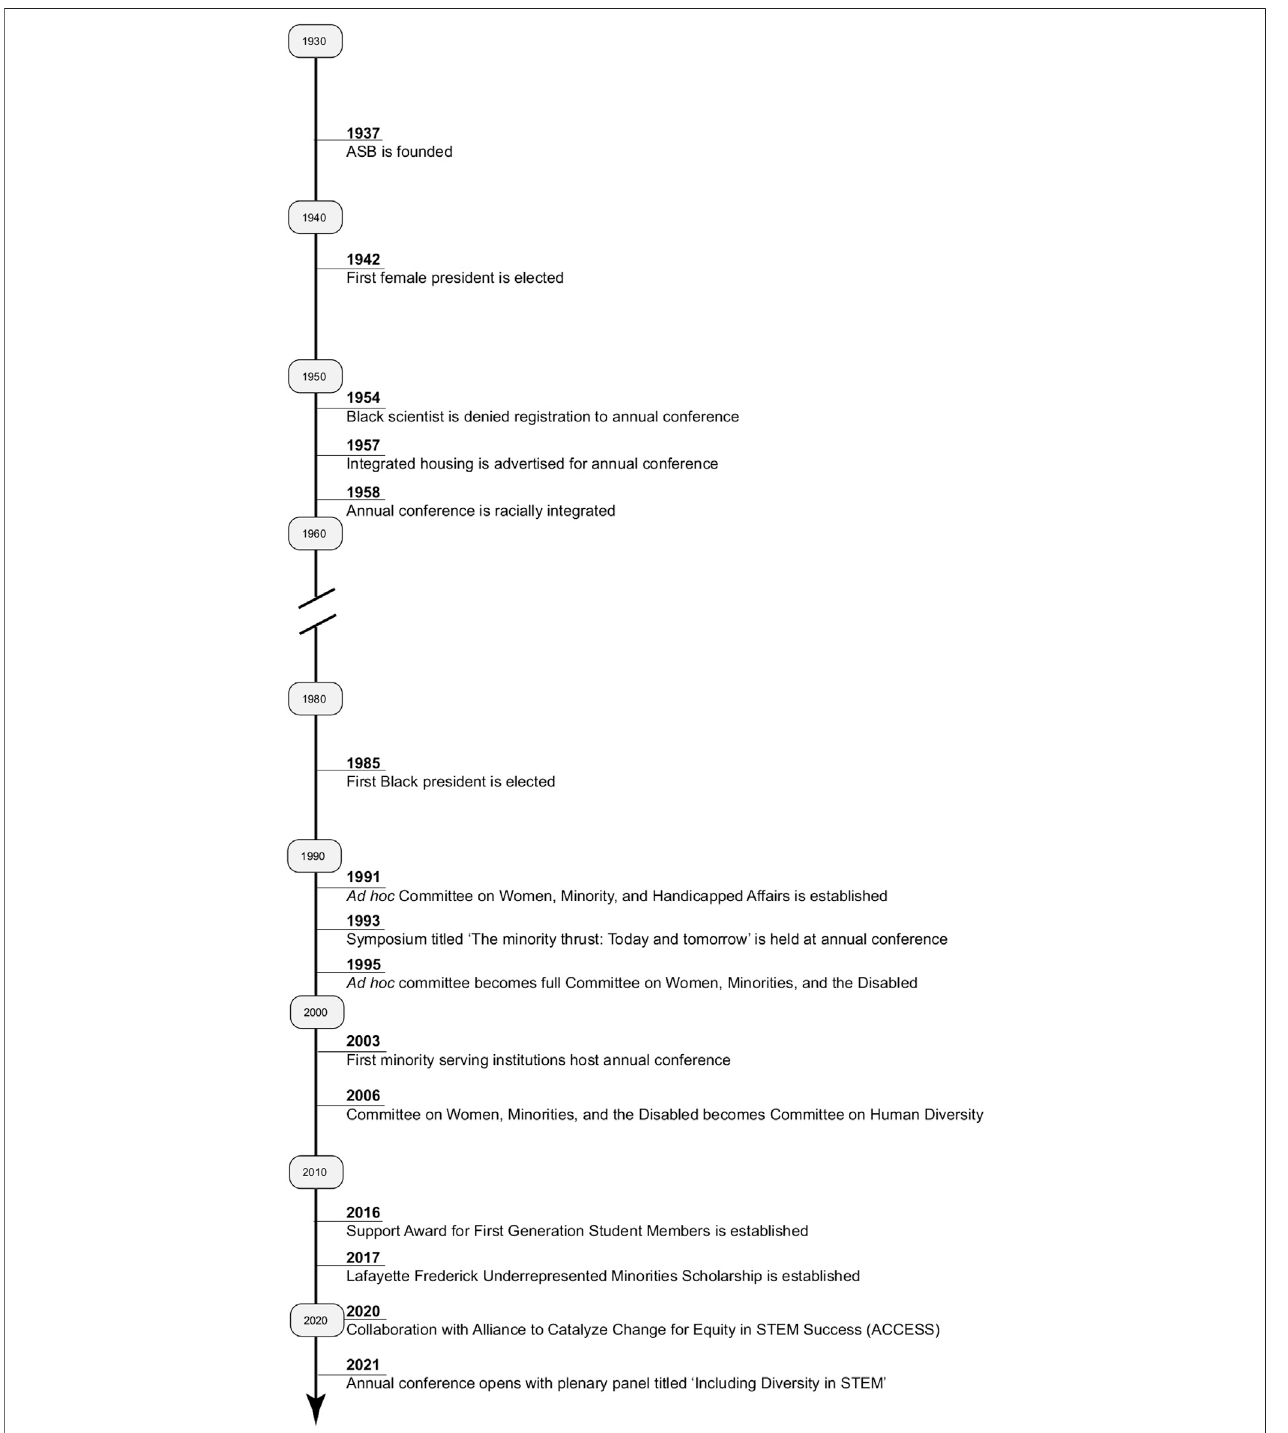
FIGURE 1 | A reconstructed history of the Association of Southeastern Biologists (ASB) highlighting events covered in this perspective.